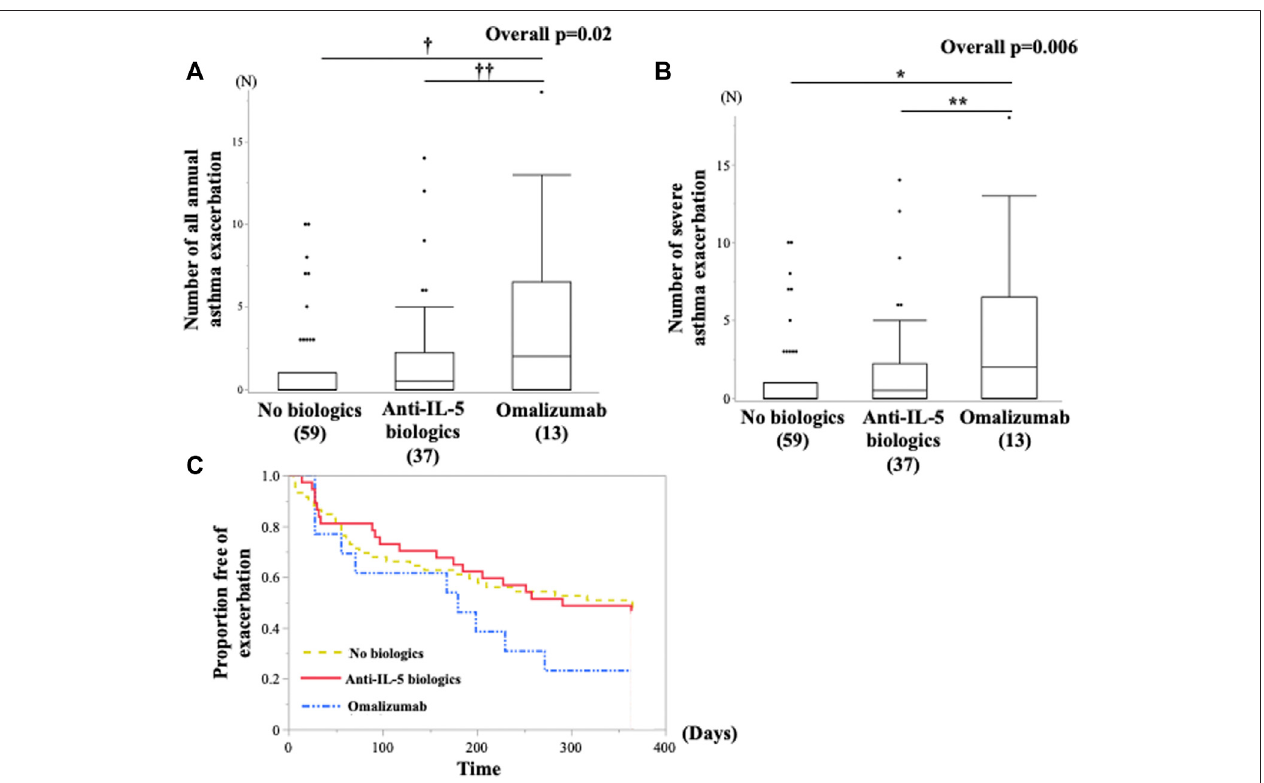
FIGURE 4 | Comparison of the future risk of asthma exacerbations after the entry between the groups of biologics use annual subsequent (A) all asthma exacerbationsand (B) severeasthmaexacerbationswasexaminedusingtheKruskal – WallistestandBonferronicorrectionforposthocpairwiseanalyses. (C) Allasthma exacerbations-free time from the entry are examined using Kaplan – Meier analysis. (A)* vs. no biologics, p = 0.001; ** vs. mepolizumab and benralizumab, p = 0.01. (B) † vs. no biologics, p = 0.0007; †† vs. mepolizumab and benralizumab, p = 0.01.